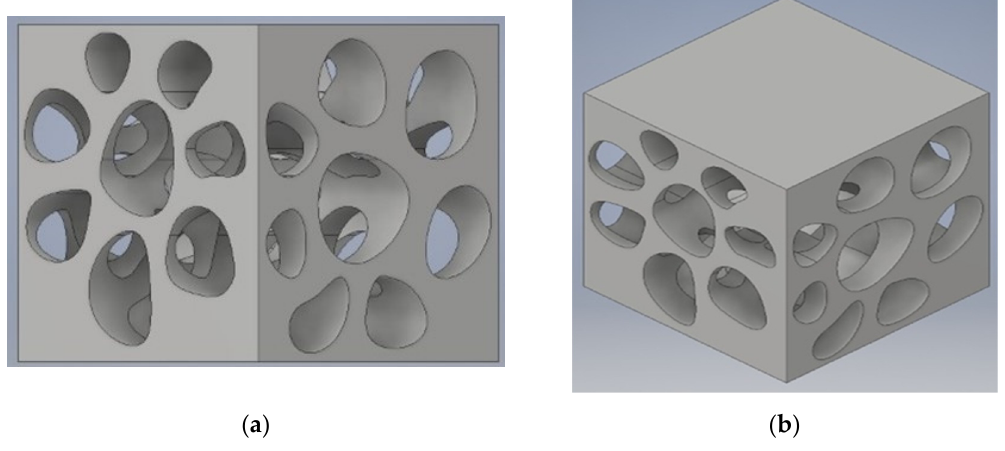
Figure 9. ( a ) Elaeocarpus ganitrus model front view; ( b ) Isometric view.